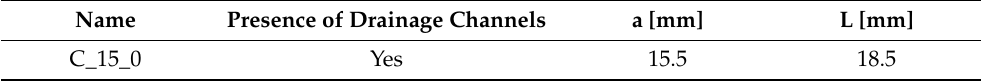
Figure 17. Details of geometry C_15_0 with streamlined drainage channels. Table 14. Geometrical details of analysed mist-wave eliminator with streamlined drainage channels.